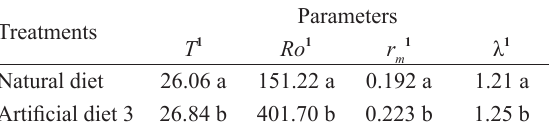
Fertility life table of Condylorrhiza vestigialis from the parameters of moths reared on natural and artificial diets. Mean generation time ( T ), net reproductive rate ( Ro ), intrinsic rate of increase ( r ) and finite rate of increase m